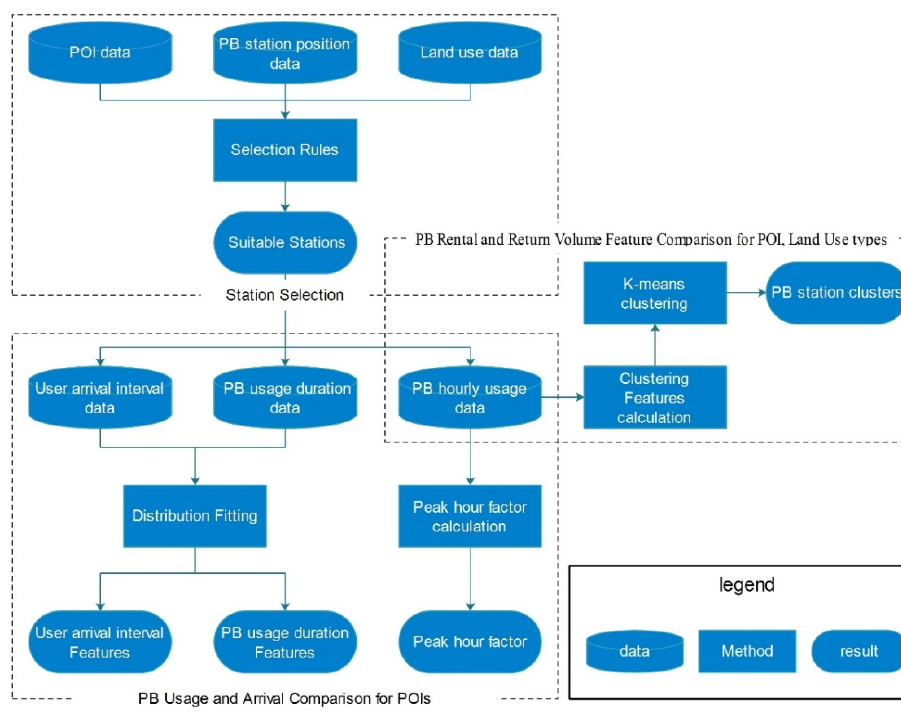
Figure 2. Technology pathway of the study.